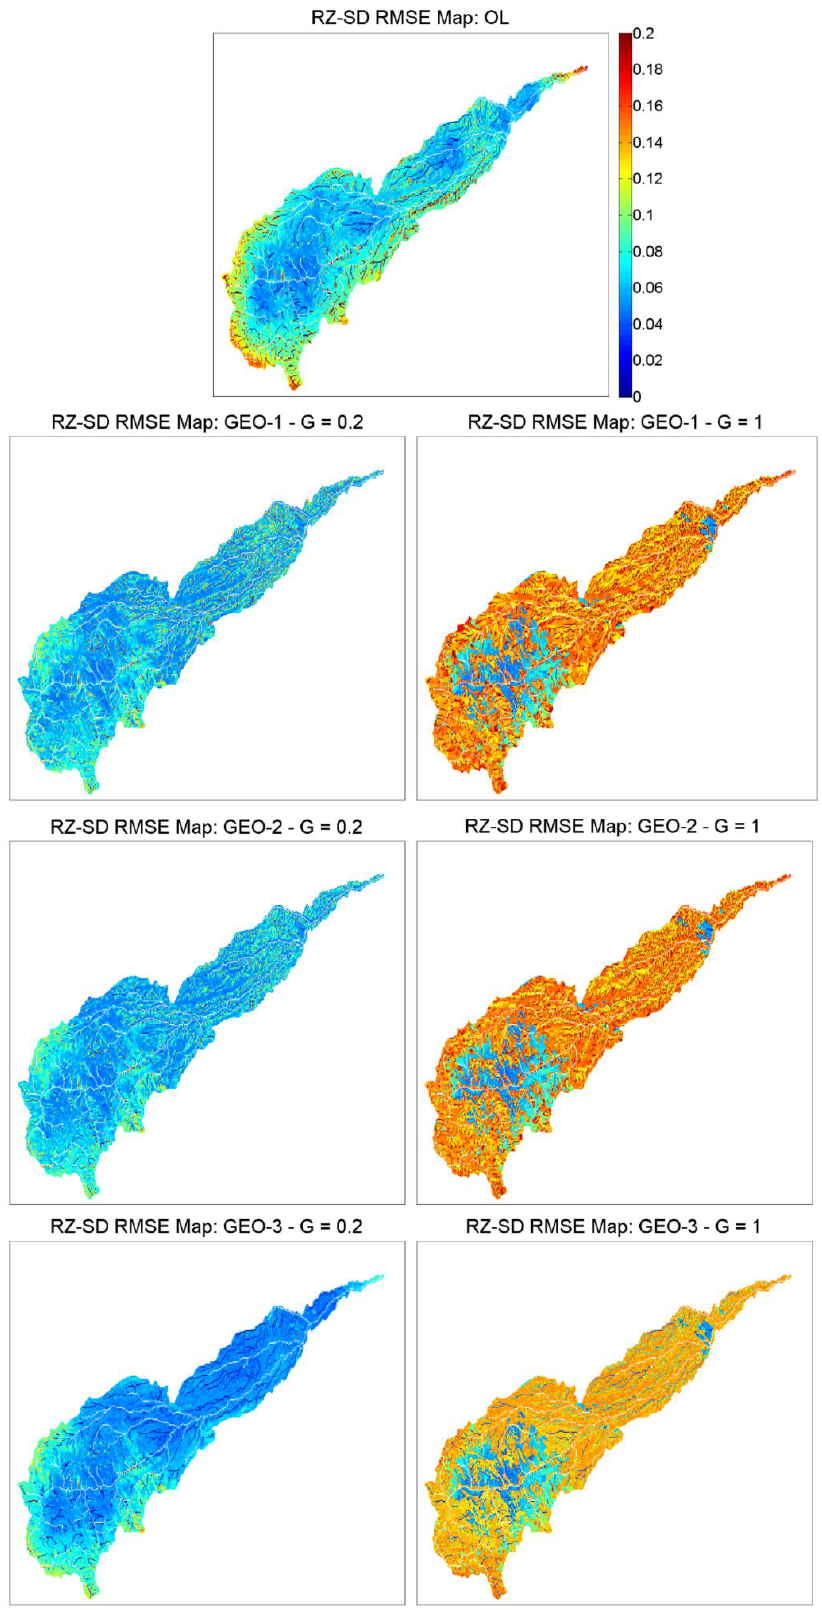
Figure 12. Comparison of RMSE maps generated by the OL run (i.e., G = 0) and the one generated by assimilating GEO SAR-like SM products, with G values equal to 0.2 and 1.